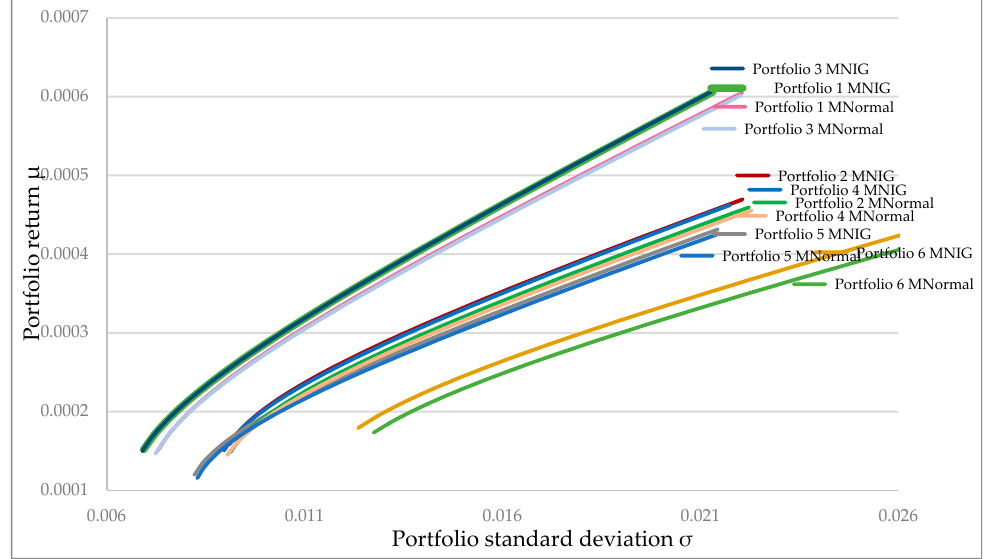
Figure 1. Efficient frontier curves for portfolios (described in Table 3) considering the MNIG and Empirical sample (MNormal) variance–covariance matrix. Elaborated by authors with data from Bloomberg.